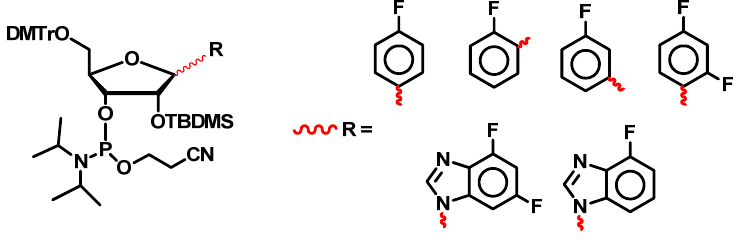
Figure 8. Monomer building blocks for the incorporation of fluorine derivative into RNA oligonucleotides by solid-phase